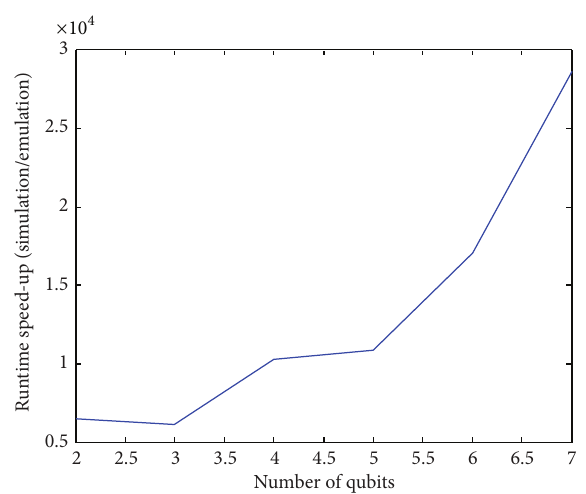
Figure 20: Runtime speed-up against number of qubits in Grover’s search